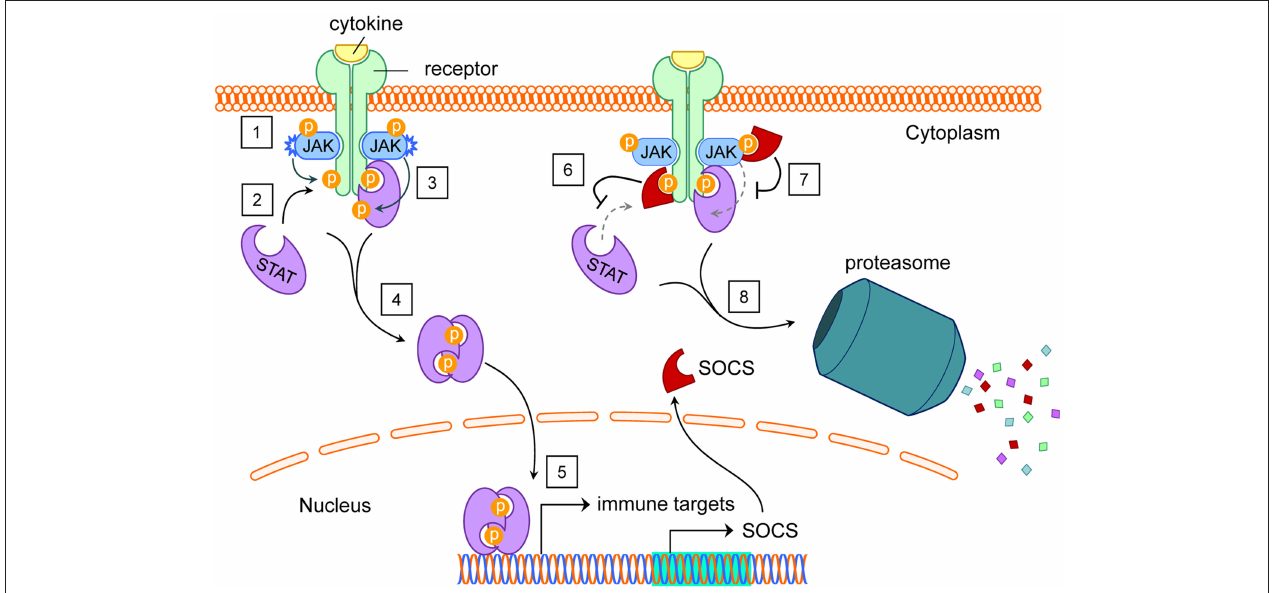
FIGURE 2 | SOCS induction by and inhibition of the JAK/STAT pathway. (1) Extracellular cytokines cause dimerization of their cognate transmembrane receptors. This brings intracellular receptor-associated JAK proteins into proximity to cross-phosphorylate each other and tyrosine residues on the receptors. (2) STAT proteins dock at phosphotyrosines on intracellular receptor subunits. (3) JAK proteins phosphorylate STAT proteins, activating them. (4) Activated STAT proteins undock from their receptors, dimerize, and translocate to the nucleus. (5) STAT proteins act as transcription factors for dozens of immune targets, including SOCS. (6) Functioning in the cytoplasm, SOCS proteins can bind various phosphotyrosines on intracellular receptors, blocking STATs from their native docking sites. (7) With their KIR domains, SOCS1 and SOCS3 can inhibit the kinase activity of JAK proteins, preventing tyrosine phosphorylation of STAT proteins. (8) SOCS boxes facilitate ubiquitination of SOCS-bound protein targets for proteasomal degradation. Abbreviations: suppressor of cytokine signaling (SOCS), Janus kinase (JAK), signal transducers and activators of transcription (STAT), kinase inhibitory region (KIR). See Akhtar and Benveniste (